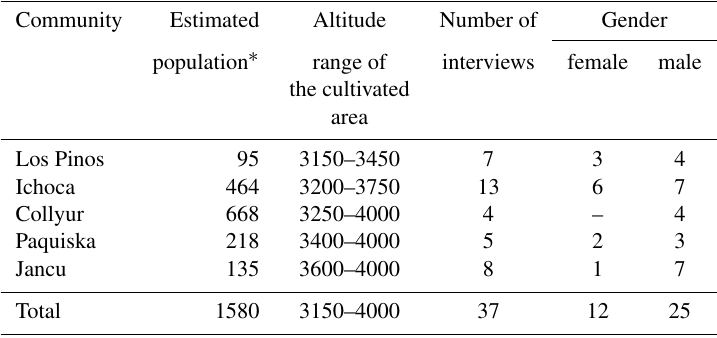
Table 1. List of interviews of farmers in the communities of Cuenca Auqui. Community Estimated Altitude Number of Gender range of the